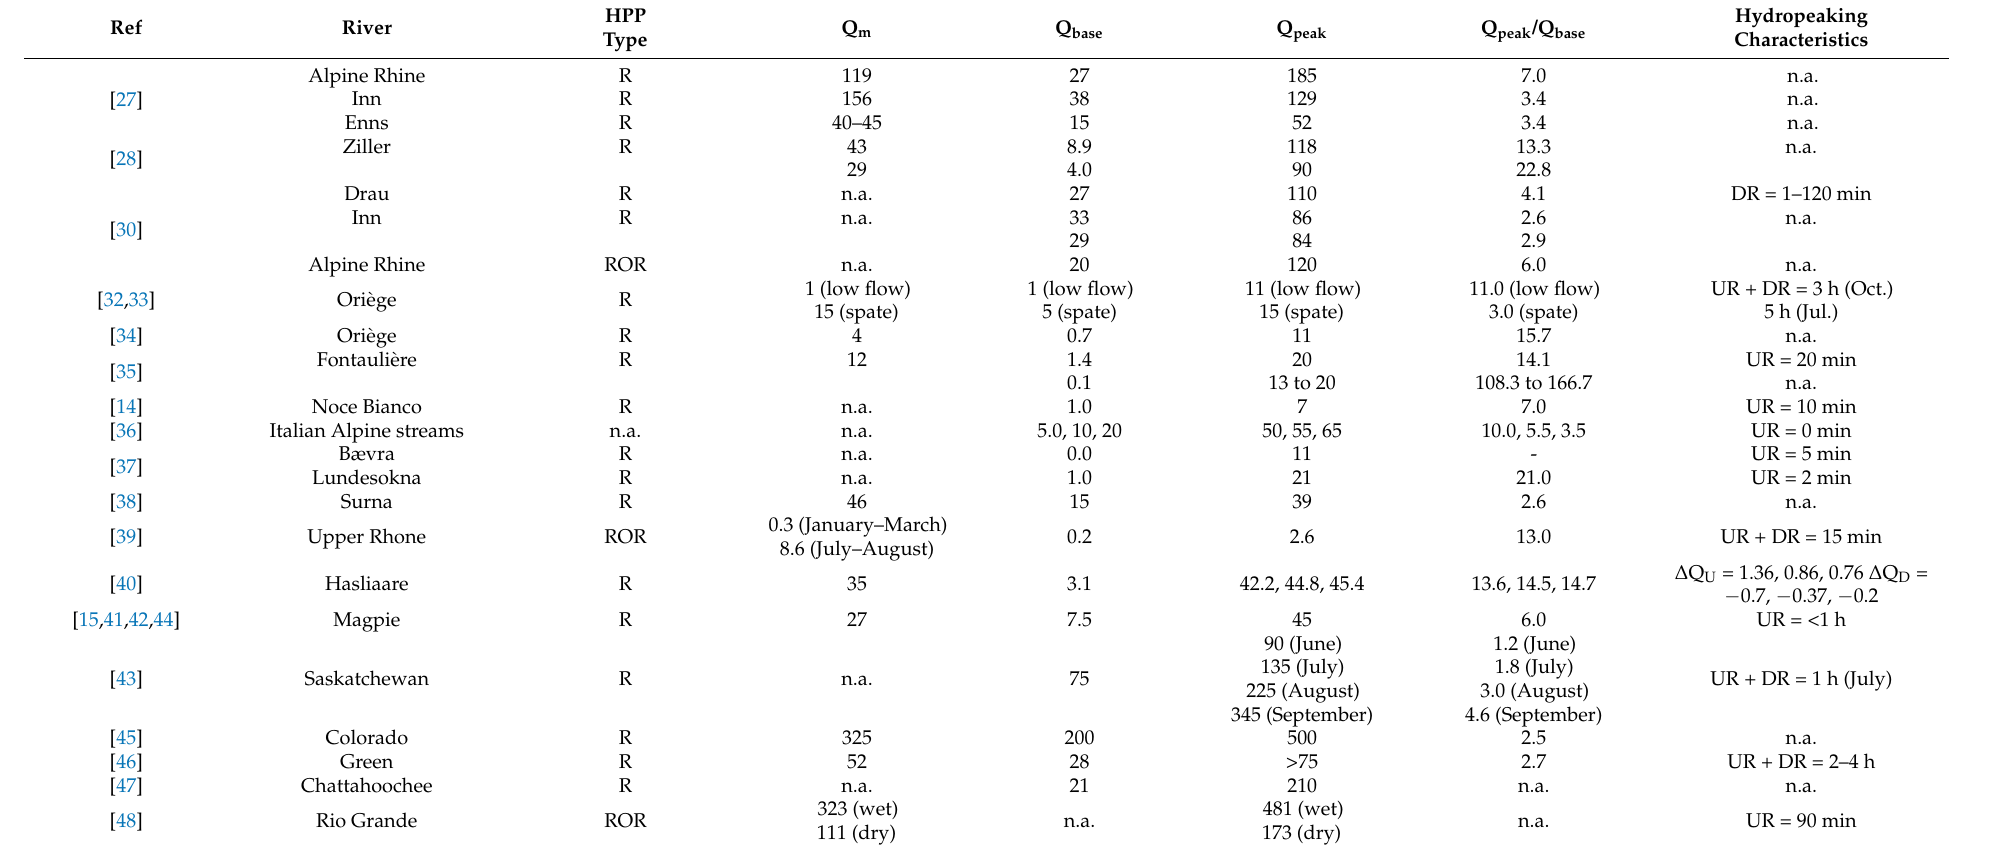
Table 3. Main characteristics of the study contexts of the selected papers. Ref = reference, HPP = hydropower plant, R = reservoir, ROR = run of the river, Q m (m 3 /s) = mean annual flow, Q base (m 3 /s) = minimum discharge, Q peak (m 3 /s) = peak discharge, UR = up-ramping phase, DR = down-ramping phase, ∆ Q U (m 3 /s · min − 1 ) = up-ramping rate, ∆ Q D (m 3 /s · min − 1 ) = down-ramping rate, n.a. = not